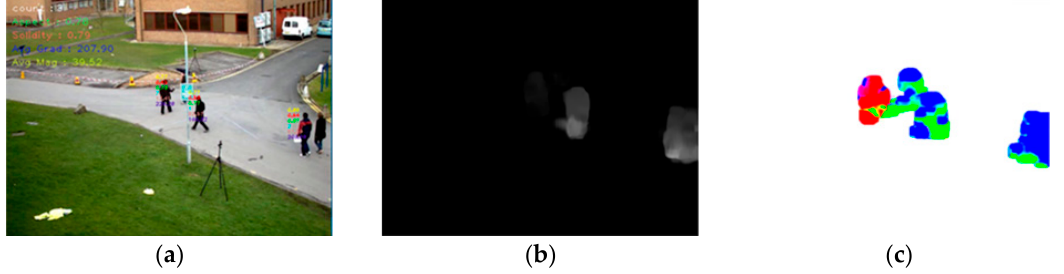
Figure 3. Magnitude and gradient feature map. ( a ) original frame; ( b ) F mag ; ( c ) F grad.